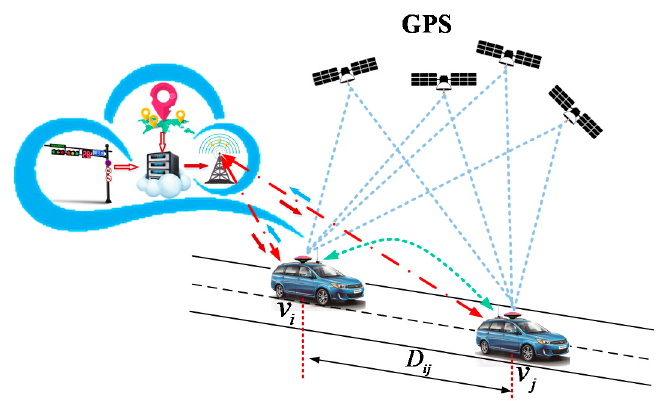
Figure 1. Cooperative localization by using multi-source information fusion.